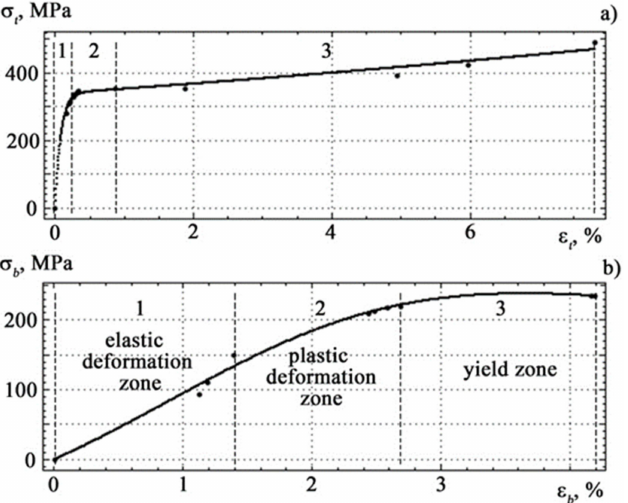
Figure 8. Relationship between strength and deformation properties under different loading condi- tions for tension ( a ) and bending ( b ).